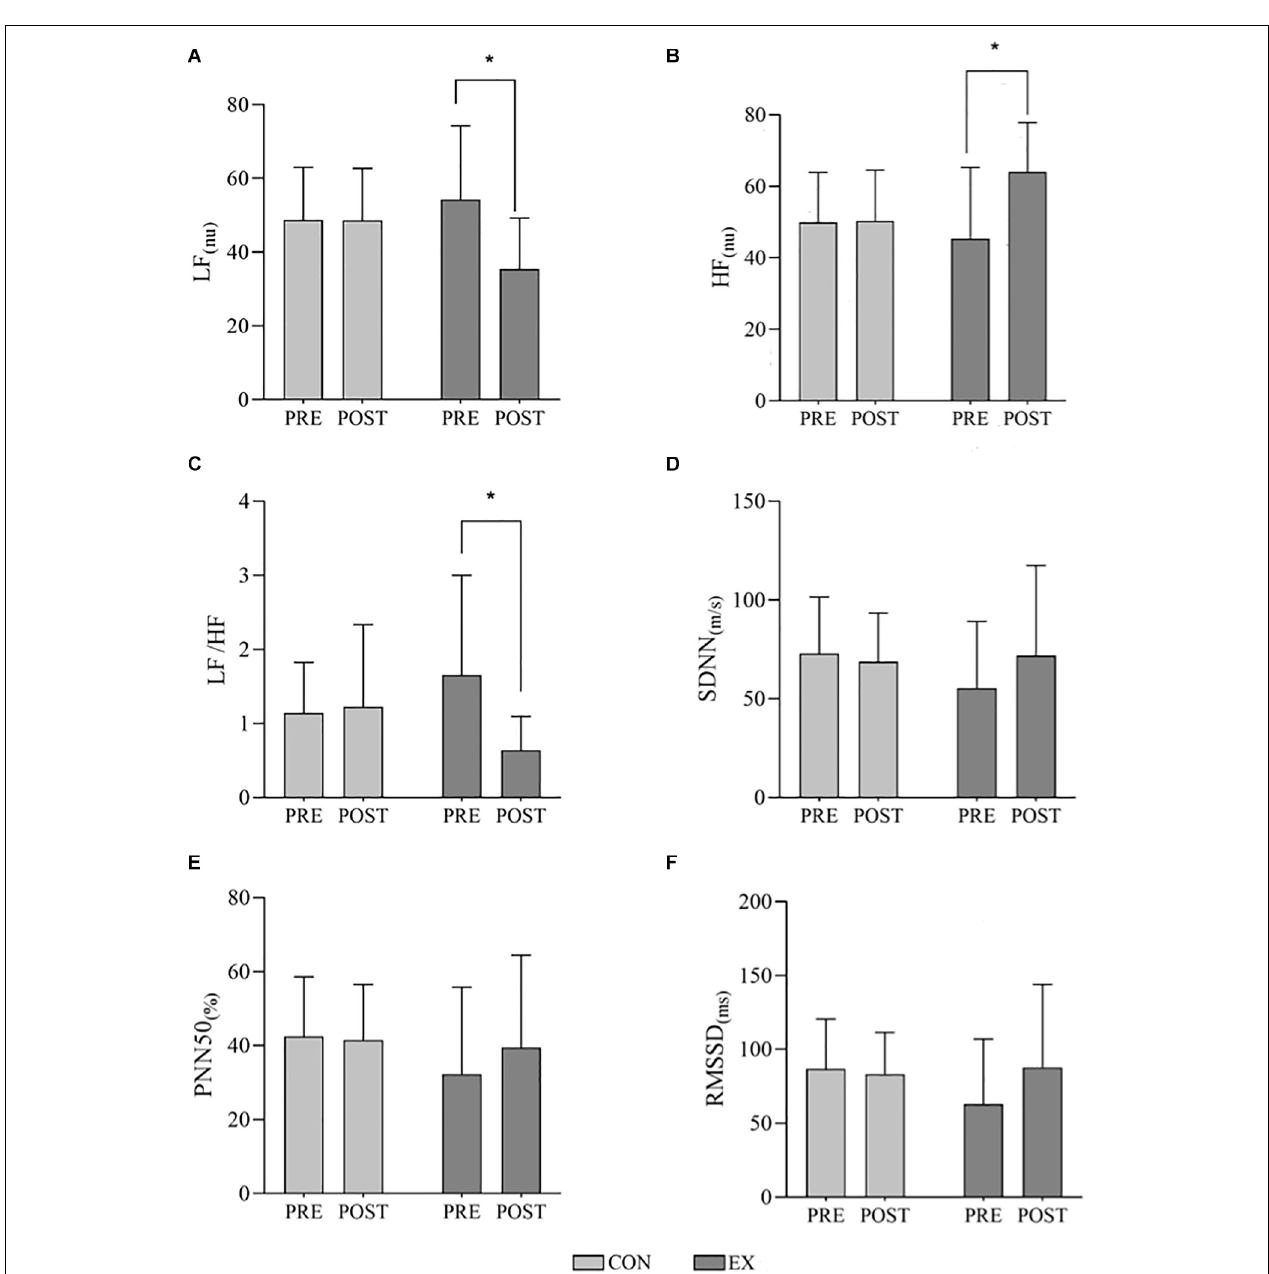
FIGURE 2 | Effects of a short-term resistance-training program on heart rate variability (HRV) in children with cystic fibrosis. (A) LF, low frequency band; (B) HF, high frequency band; (C) LF/HF ratio; (D) SDNN, standard deviation of R-R intervals; (E) PNN50, percentage of successive R-R intervals that differ by more than 50 ms; and (F) RMSSD, root mean square of successive differences between normal heartbeats. ms, milliseconds; nu, normalized units; CON, control group; EX, exercise group. Data presented as mean and standard deviation. Differences were analyzed using a two-way analysis of variance (ANOVA) with repeated measures. *Indicates significant differences when p <